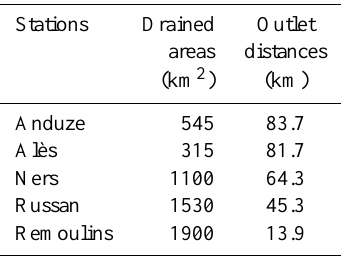
Table 1. Drained areas and outlet distances for the five stations. Stations Drained Outlet areas distances